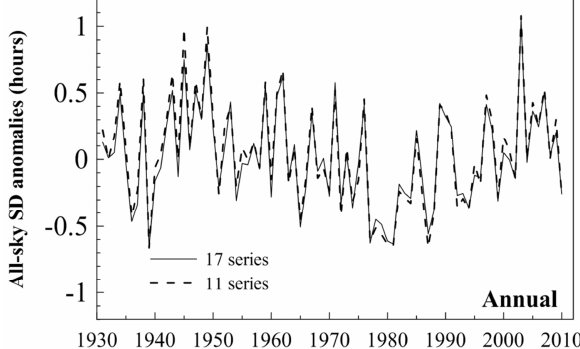
Fig. 1. Mean annual all-sky SD series from 1931 to 2010 in Switzer- land, as computed using the 17 stations (solid line) and a subset of the 11 stations (shaded line) with collocated homogeneous clear- sky SD series. Both annual series show a similar decadal variability and are highly correlated ( r = 0 . 99 α < 0.01, 1931–2010 period) at interannual